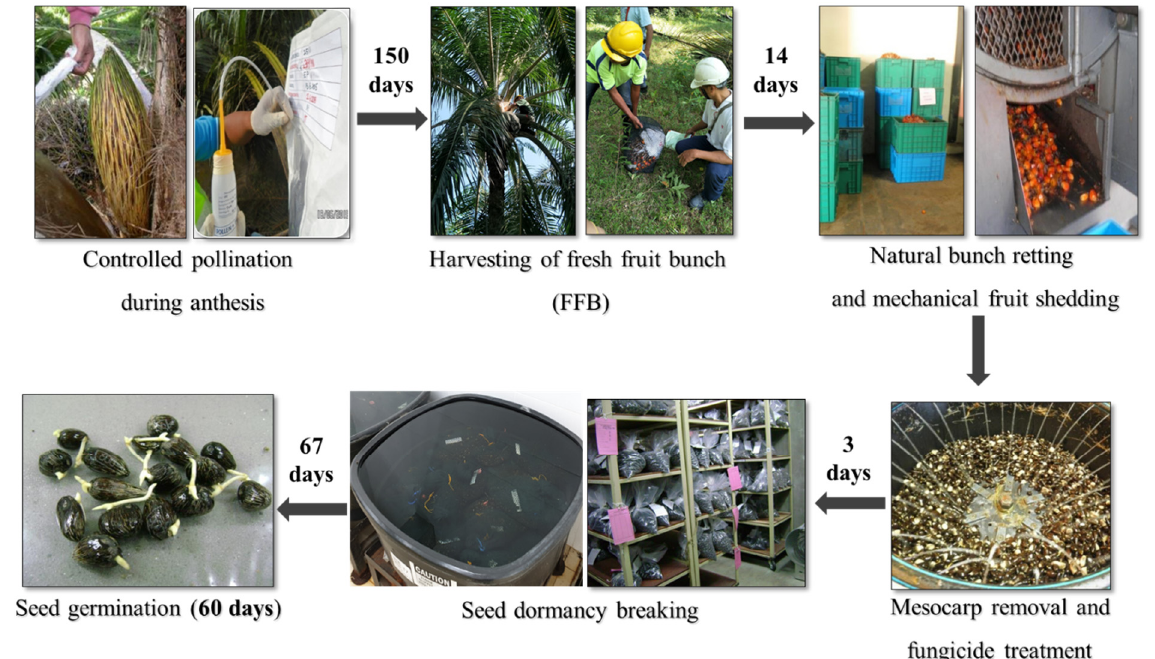
Figure 1. A process flow that involves various processes in a 10-month period for oil palm seed production. Conventional bunch retting allows natural abscission of fruits from spikelets, in which the process may take up to 14 days before fruit shedding by mechanical means.